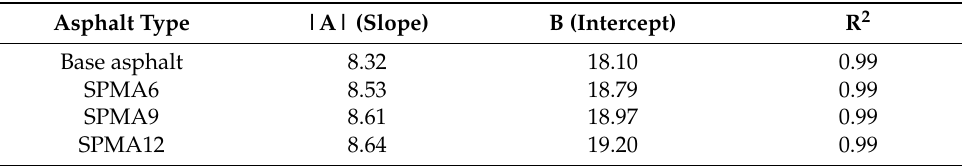
Figure 11. Temperature sensibility. Table 14. The fitting result of temperature sensibility.